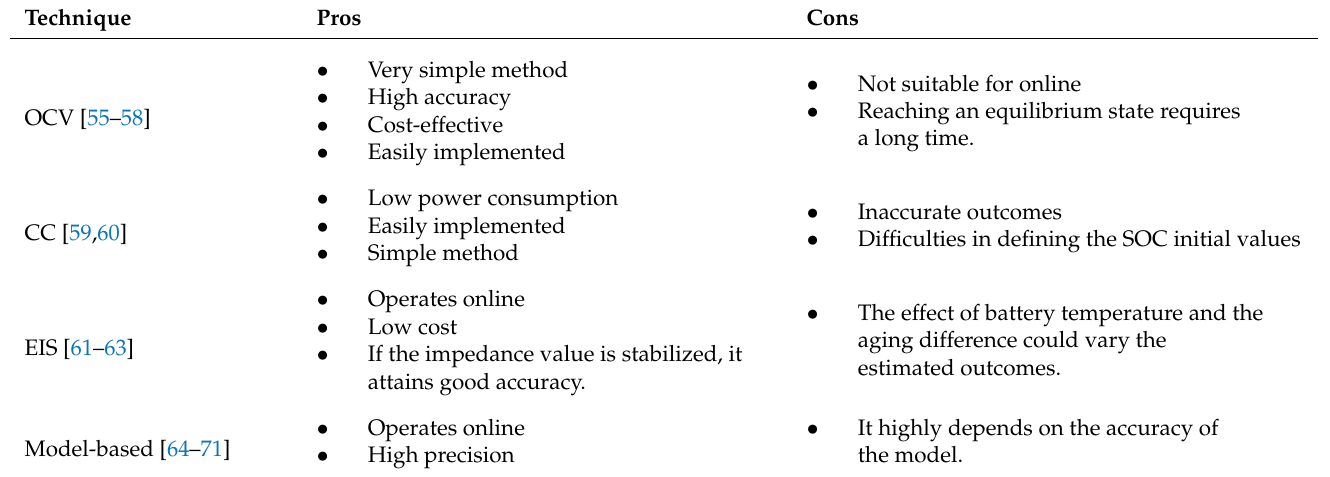
Table 5. Analysis of the different conventional SOC estimation